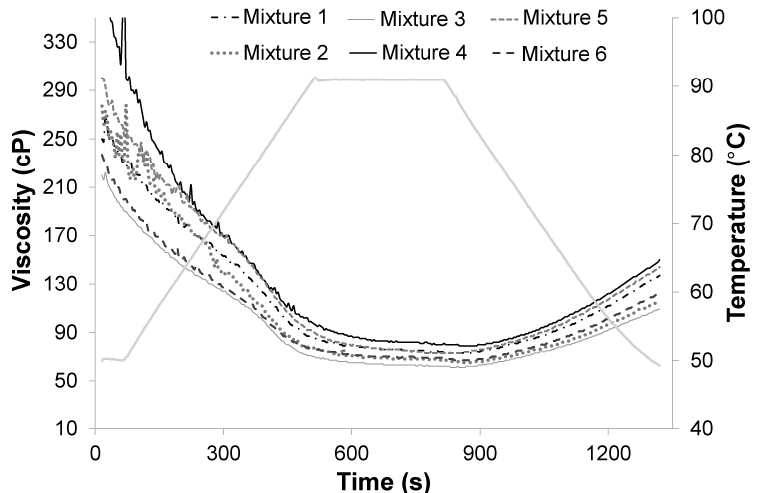
Figure 2. Amylographic viscosity profile of extruded products obtained with Rapid Visco Analyzer (RVA).